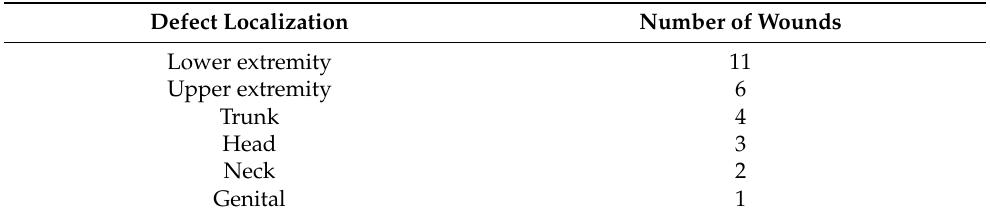
Figure 1. Entities of complex wounds and the relative proportions of each entity in the total popu- lation ( n = 20). The localization of the included complex wounds covered the entire body and in- cluded in total 27 complex wounds in 20 patients. The majority of the wounds (40.7%) were localized in the lower extremity. Table 2 shows in detail the localization of the 27 complex wounds. Table 2. Defect localization of complex wounds in the study population ( n = 20). Overall 27 com- plex wounds were included.